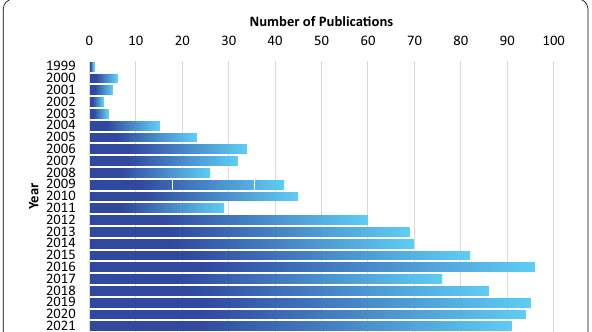
Fig. 6 Publication trend in artefact removal from neuronal signals. The results were obtained by searching scientific databases with the term "artefact removal"